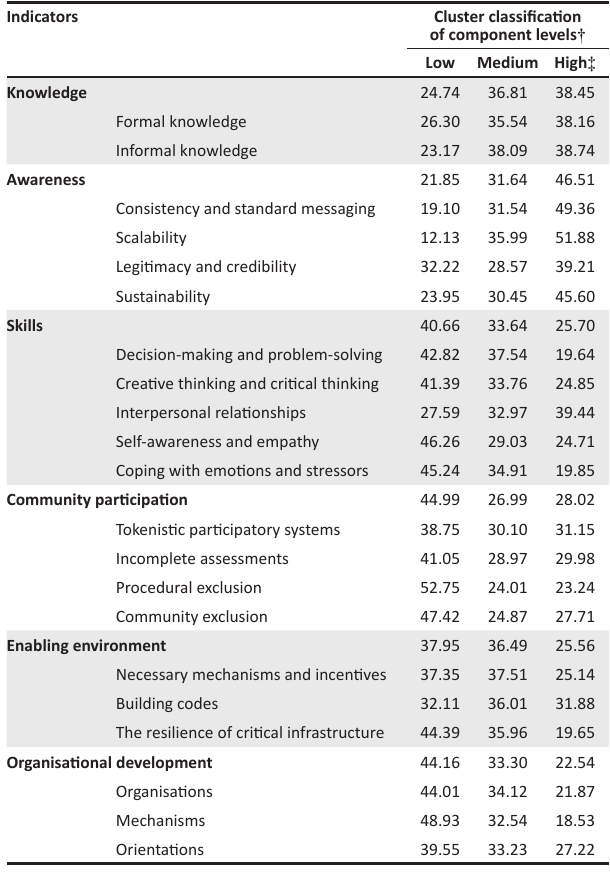
TABLE 7: Cluster classification of the basic components of disaster risk management.